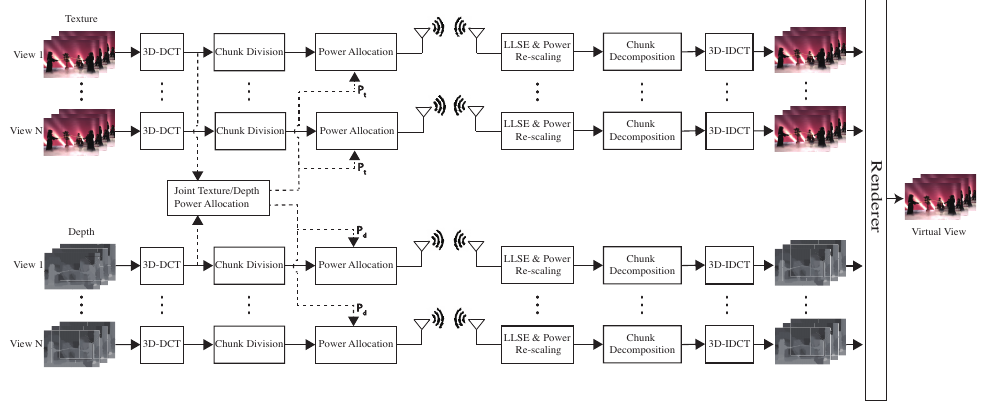
Figure 1. Diagram of the proposed 3D video